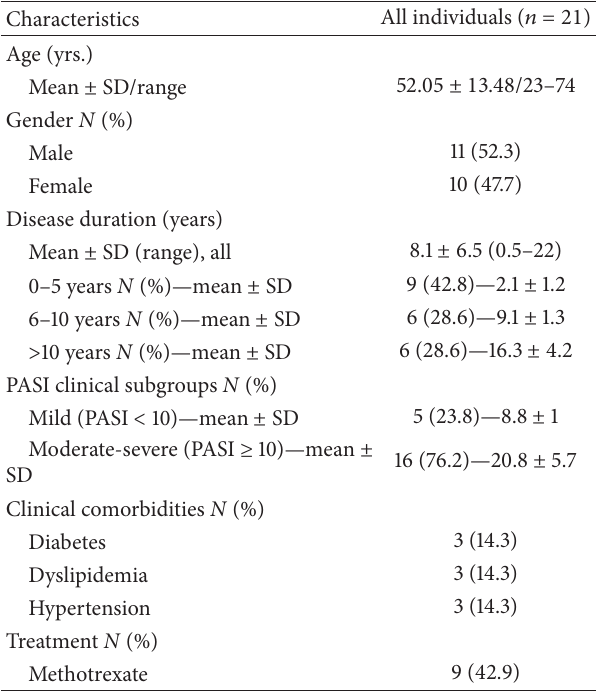
Table 1: Clinical features of psoriatic patients from Brazil northeast a